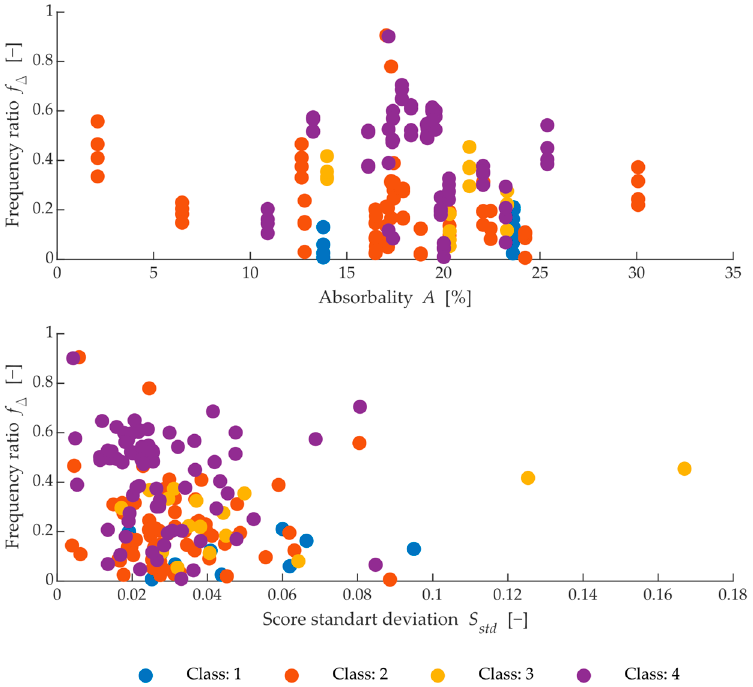
Figure 16. Comparison of absorbability, mean score value (upper), prominence of dominant peak and skewness (bottom).